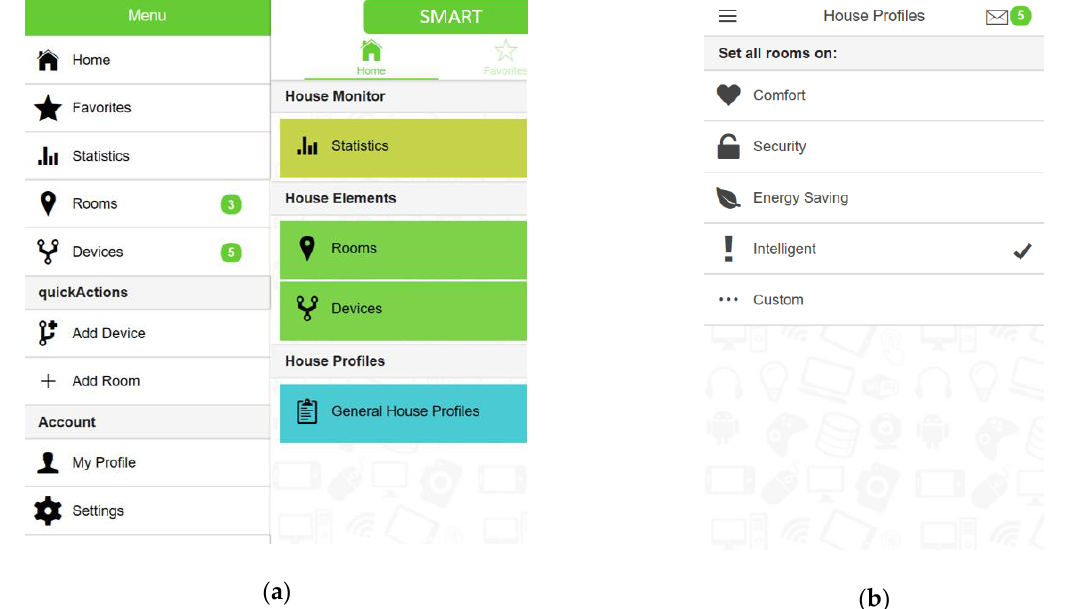
Figure 4. Intelligent mode interfaces: ( a ) main menu from which the configuration house profile options can be accessed; and ( b ) house profile